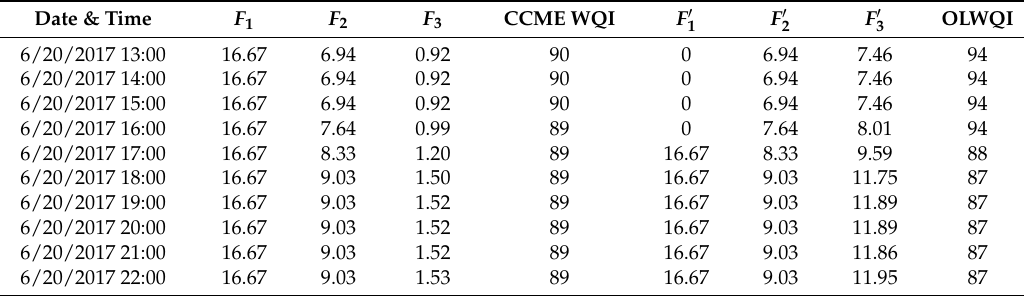
Table 5. Indexing Results using Data Collected at the First Landing Station in CBIBS.